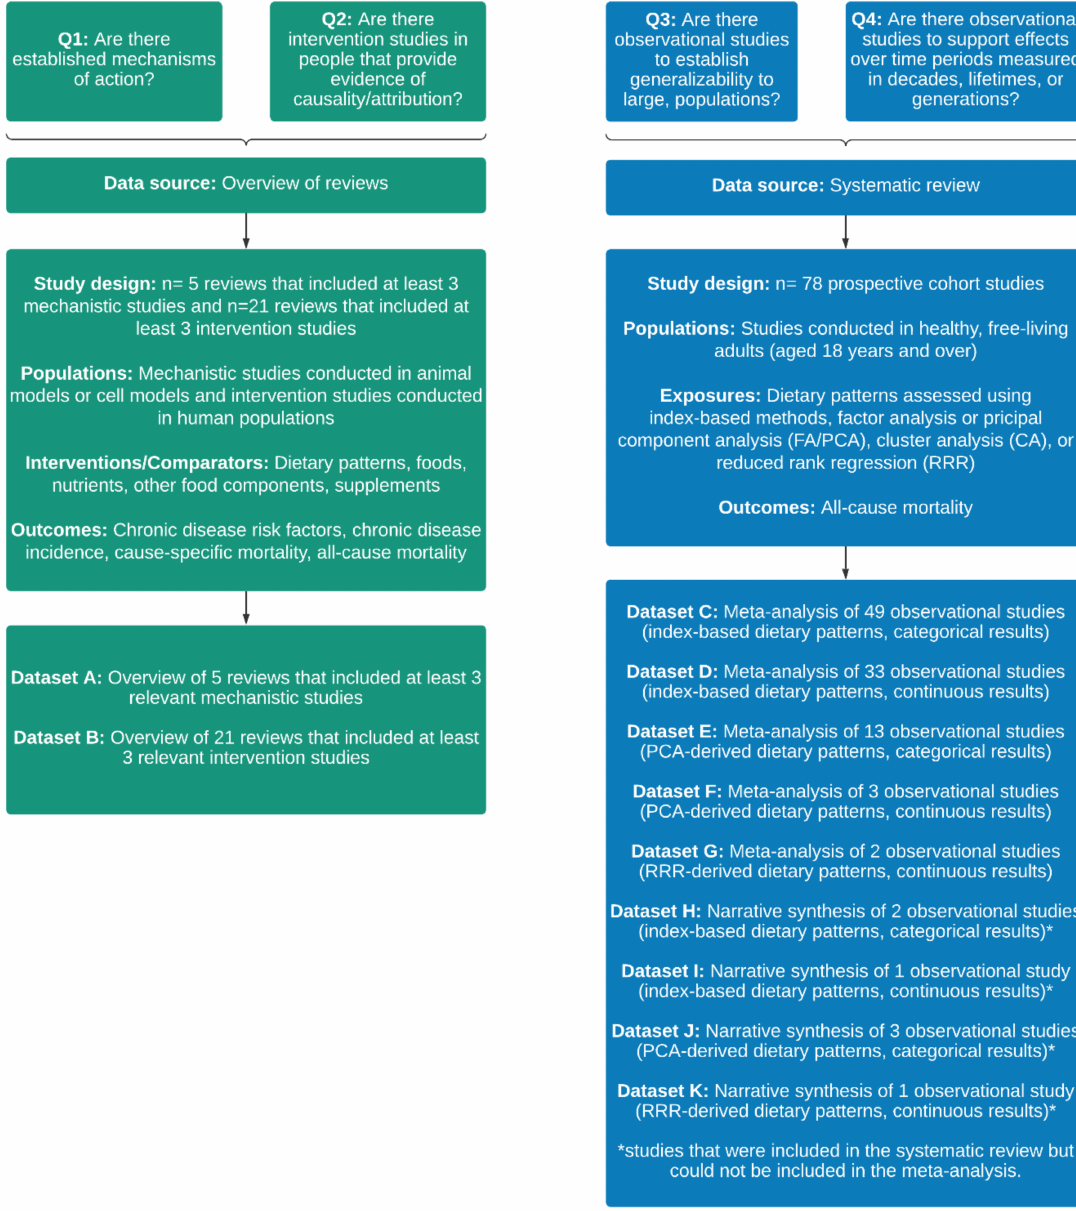
Figure 1. Overview of the data sources and datasets that were used in the application of the Hierar- chies of Evidence Applied to Lifestyle Medicine (HEALM)